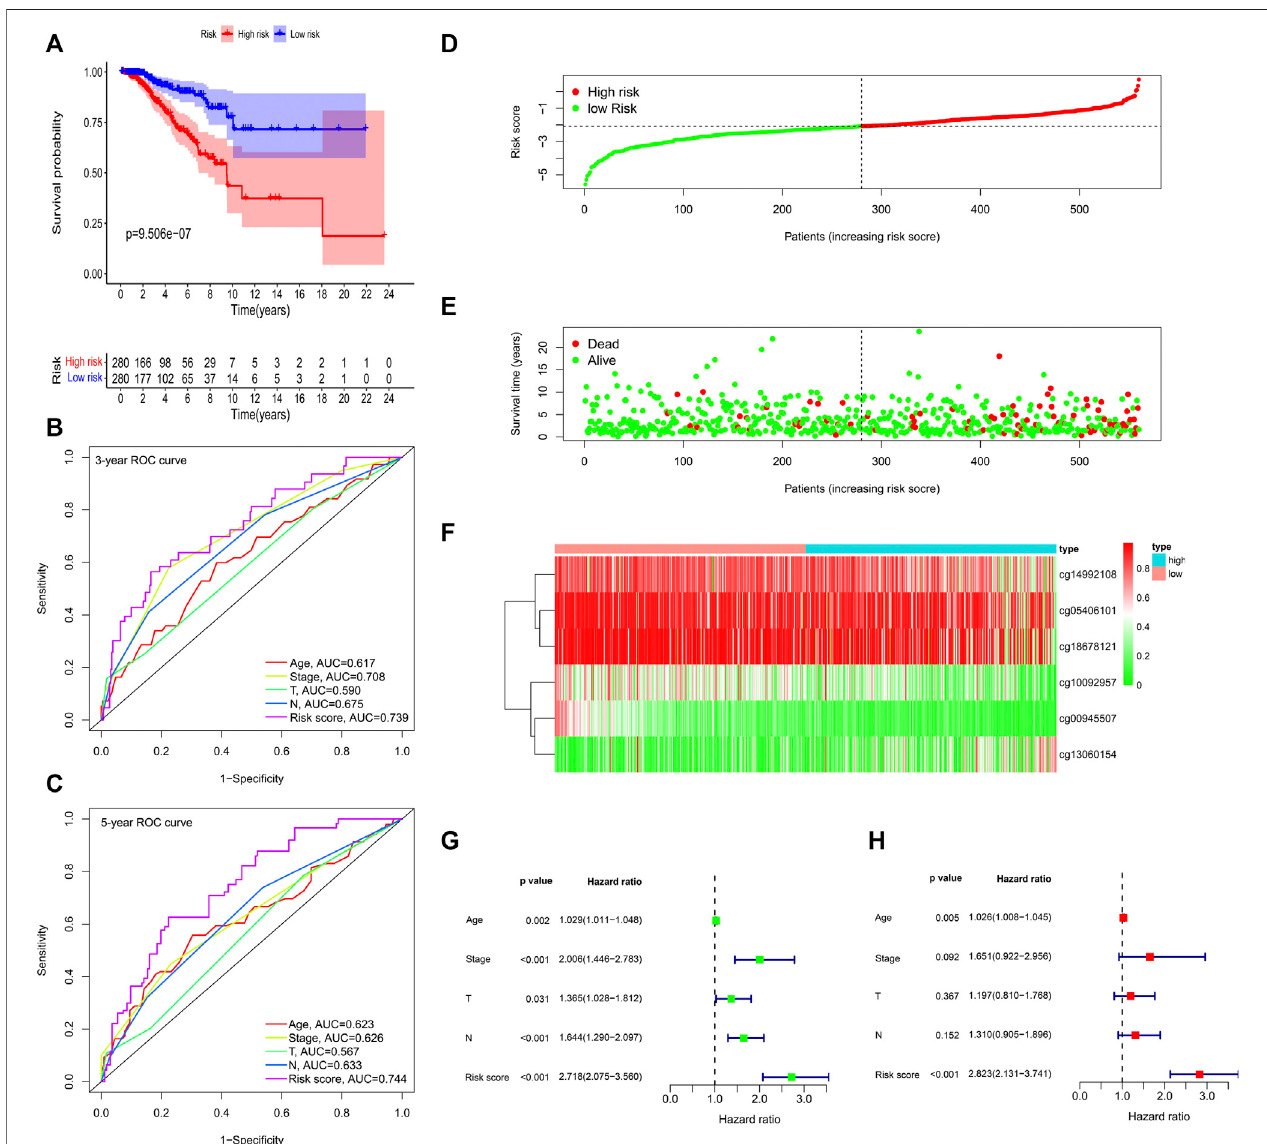
FIGURE 5 | Methylation prognostic model assessment in 560 breast cancer samples. (A) Survival analysis between the high-risk and low-risk groups. (B,C) The time-dependent receiver operating characteristic (ROC) curves at 3 and 5 years. (D) The risk score distribution. (E) Survival status scatter plots. (F) Heatmap of the six signature CpG loci. (G) Univariate Cox regression analysis. (H) Multivariate Cox regression